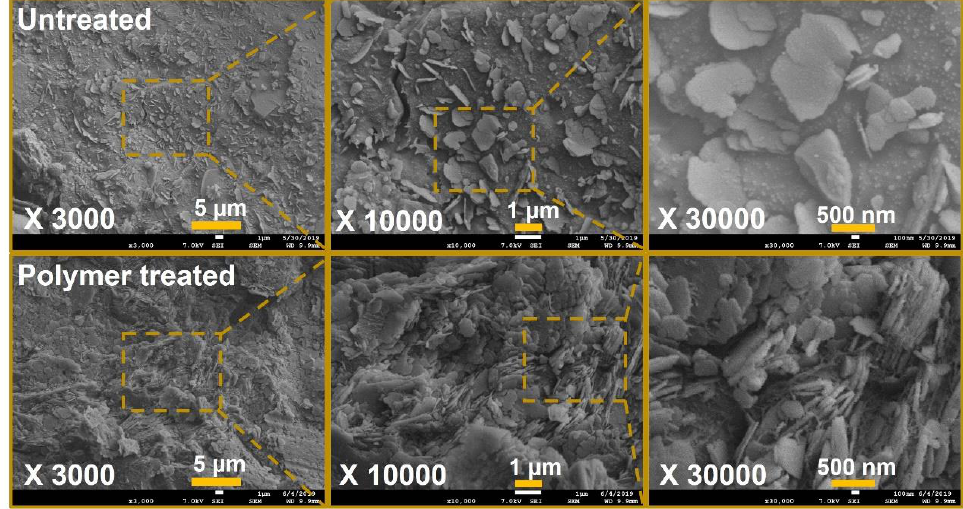
Figure 4. Cryo-SEM imaging of untreated and polymer-treated materials in three different magni- fications.